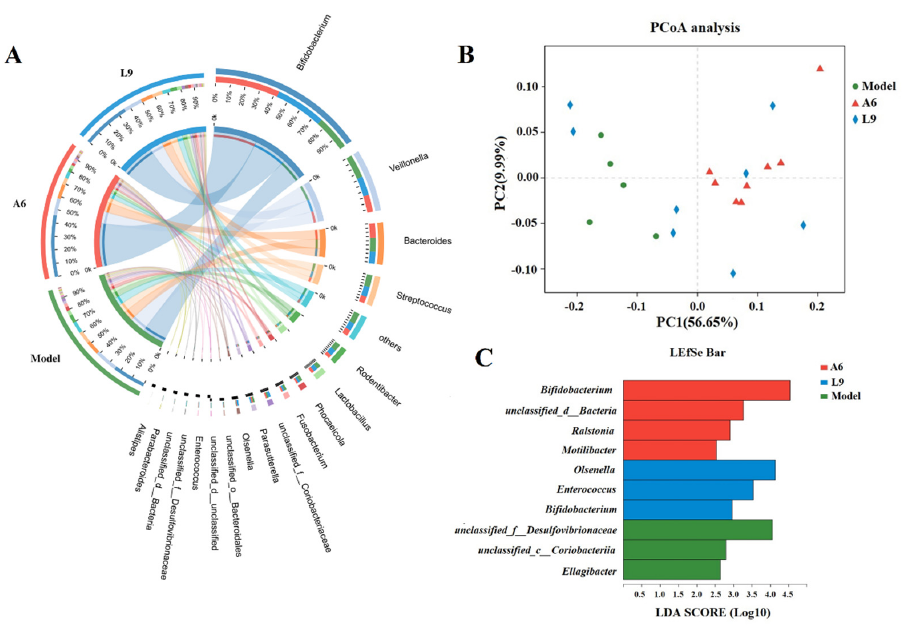
Figure 5. Taxonomic compositional changes to the subgingival microbiome after A6 or L9 intervention. ( A ) Circos diagram shows the taxonomic composition and the correspondences between samples and taxa of different groups at the genus level. ( B ) Principal coordinate analysis (PCoA) of different groups. ( C ) Linear discriminant analysis effect size (LEfSe) cladogram represents characteristic taxa associated with different treatments at the genus level.